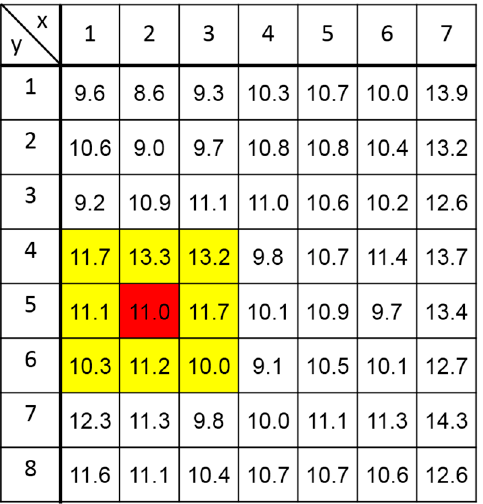
Figure 17. Map of input referred noise [e − rms ] of an 8 × 7 pixel array with cooling at − 35 °C. Highlighted 3 × 3 pixel array is used for X-ray energy spectrum measurement. A pixel (x = 2, y = 5) shown by red-colored box is used for the measurement of single pixel events. Adjacent 8 pixels shown by yellow-colored boxes are used for eliminating events of charge splitting to plural of pixels.